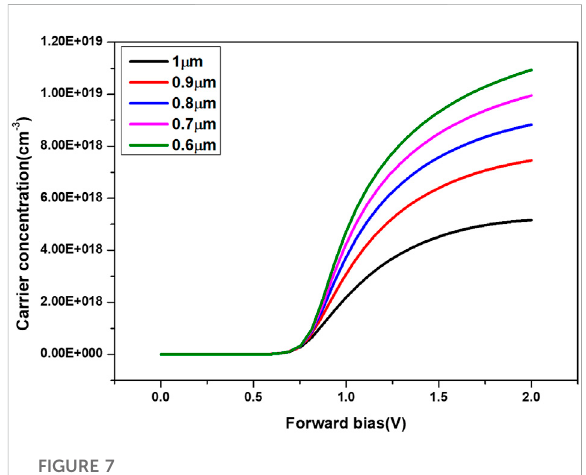
Relationship between W s and carrier injection